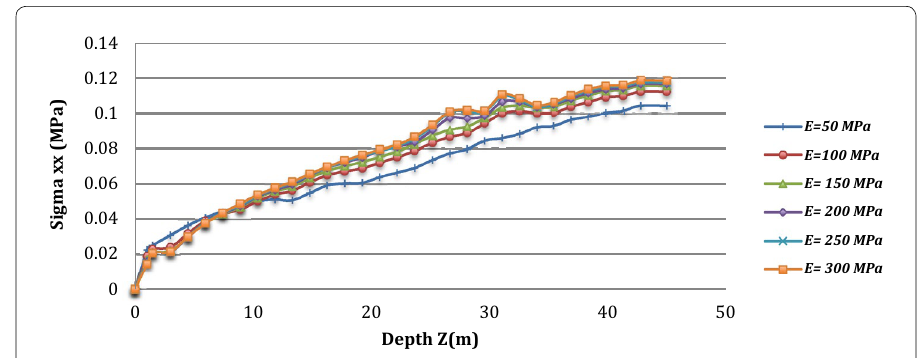
Fig. 6 Effects of Young’s modulus (E) of the backfill on horizontal stress (sigma xx) in a stope